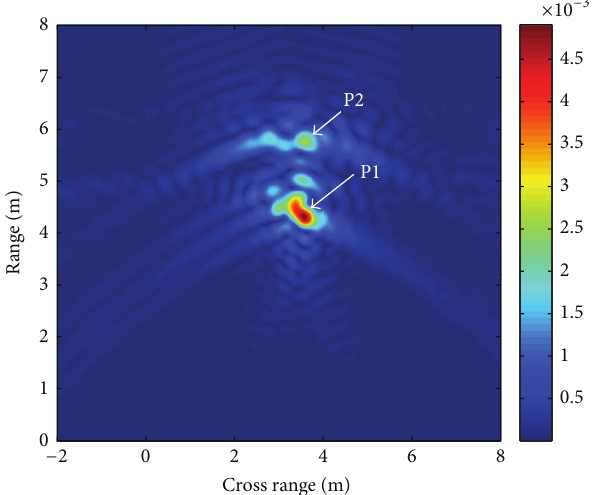
Figure 18: The original moving target imaging result in the monos- tatic mode.